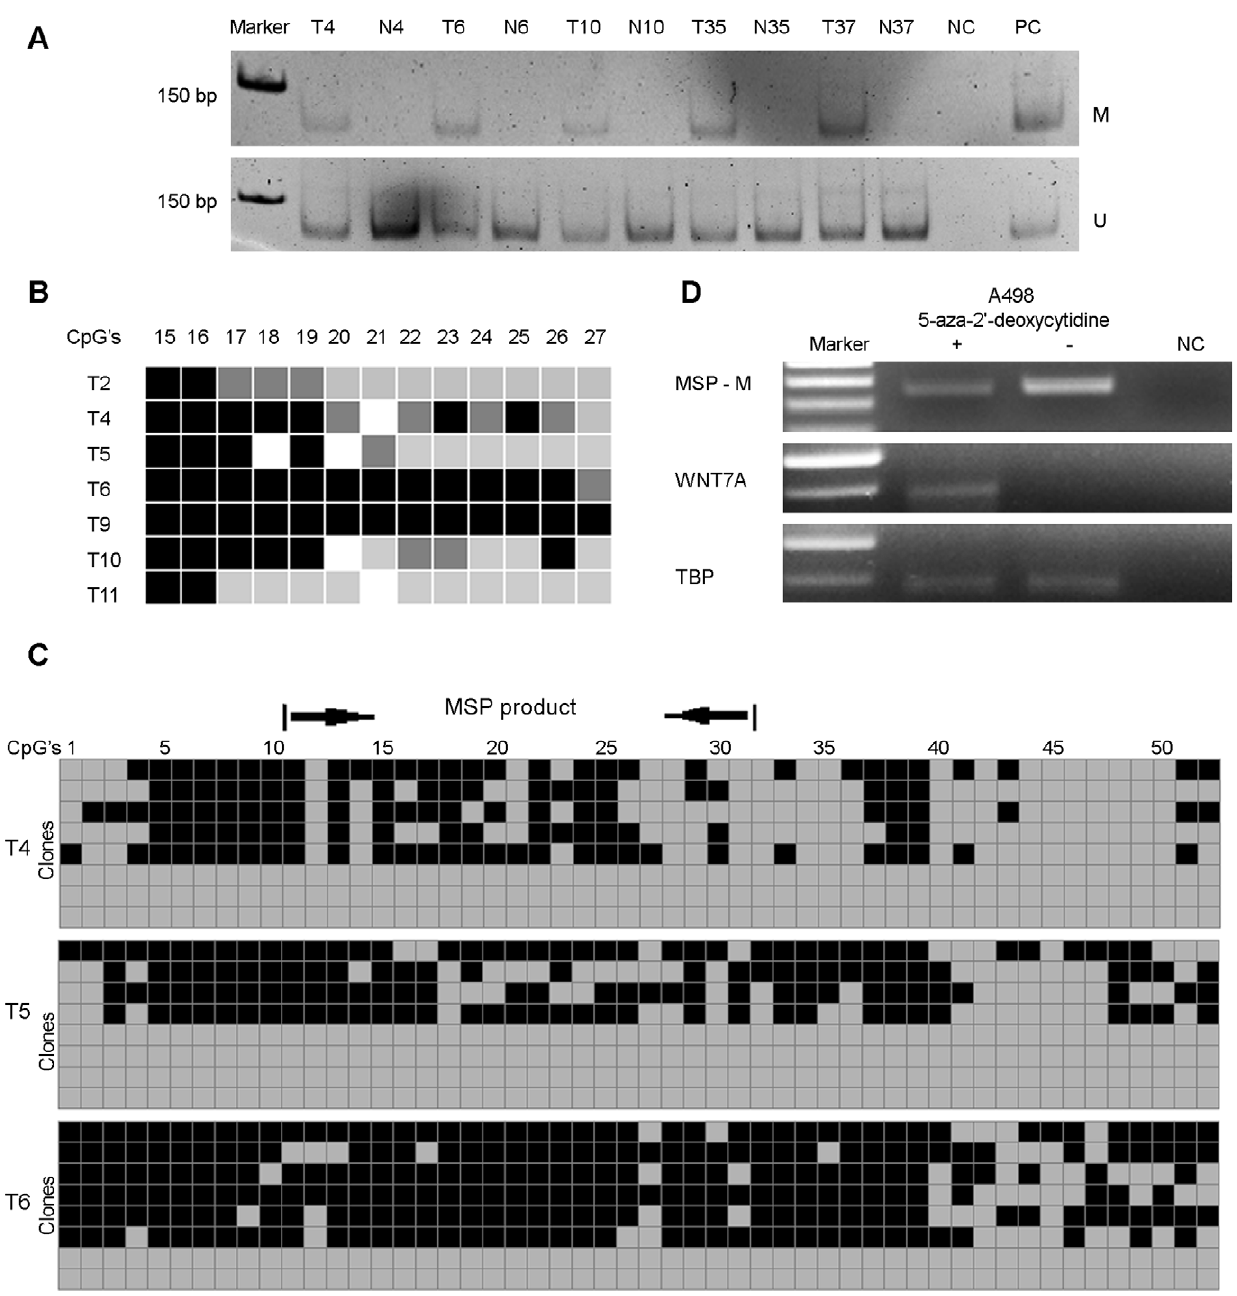
Figure 1. Study of WNT7A gene methylation status in clear cell RCC. (A). Representative MSP analysis of the WNT7A gene by using methylated (M) and unmethylated (U) specific primers, PC – positive control, M.Sssi treated or untreated normal DNA, NC – negative control (H 2 0), T4, T6, T10, T35, T37: tumor samples, N4, N6, N10, N35, N37: normal samples. (B). Sequencing of MSP products; white squares - 0–19% methylation at the CpG dinucleotide, grey squares - 20–59% methylation at the CpG dinucleotide, dark grey squares - 60–79% methylation at the CpG dinucleotide, black squares - 80–100% methylation at the CpG dinucleotide, T2, T4, T5, T6, T9, T10, T11: tumor samples. (C). Methylation status of the fifty two CpG dinucleotides of the WNT7A 5 9 -CpG island in tumor samples with a methylated WNT7A gene, where each CpG dinucleotide is shown by either a black square when methylated or a grey square when unmethylated; arrows indicate position of MSP primers, T4, T5, T6 are tumor samples. (D). Restoration of WNT7A expression by 5-aza-2 9 -deoxycytidine treatment of the A498 cell line, MSP-M - methylation analysis of the WNT7A gene by using methylated specific primers, NC – negative control (H 2 0). doi:10.1371/journal.pone.0047012.g001 ellite marker analysis. Detection of LOH was performed in 28 samples of clear cell RCCs and the adjacent non-malignant tissues for the polymorphic repeats D3S2403, D3S2385 and D3S1252. A copy number study of the chromosome 3p25 region The frequency of loss for the above-mentioned markers was 93% surrounding the WNT7A gene was performed using the microsat-